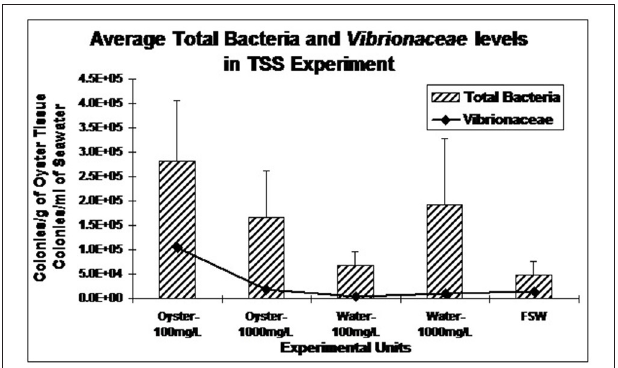
FIGURE 8 | Average total bacteria and Vibrionaceae levels ( ± standard error) in oysters from laboratory total suspended solids experiment (Fay,